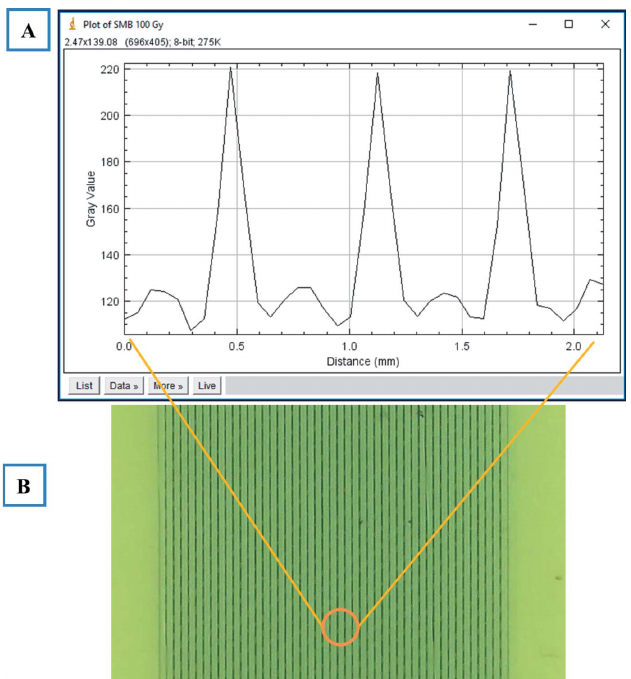
Figure 7 Radiation field exposed to 100 Gy of 90 kV SMB. (A) Dose profile plotted by ImageJ # and (B) GAFchromic TM HD-V 2 film.